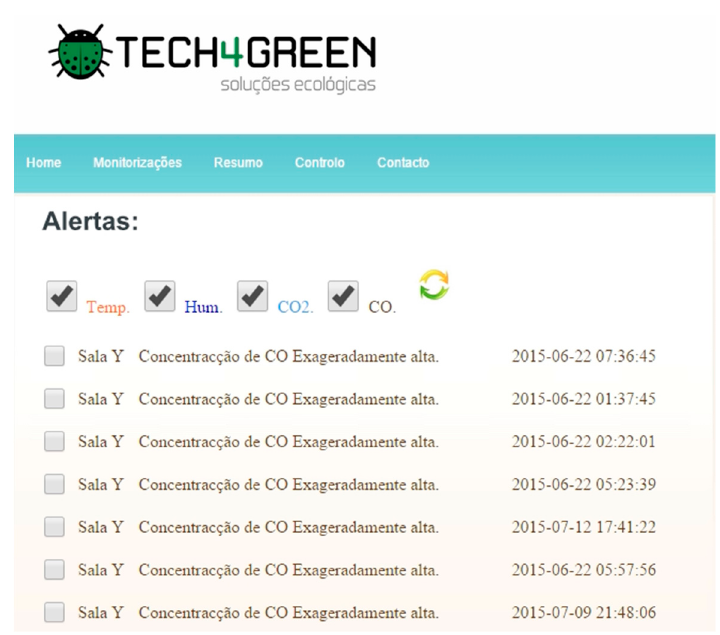
Figure 12. iAQ notifications system.